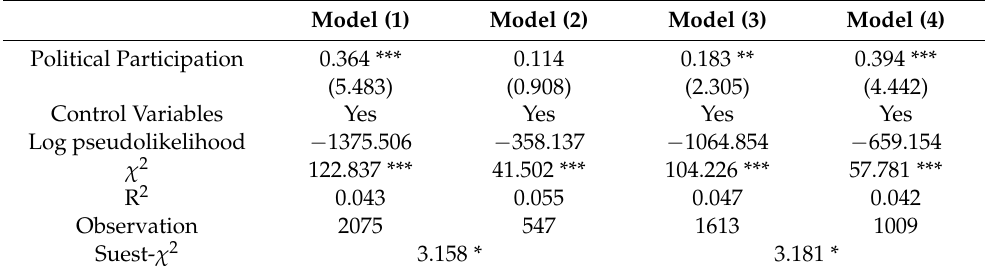
Table 4. Heterogeneity